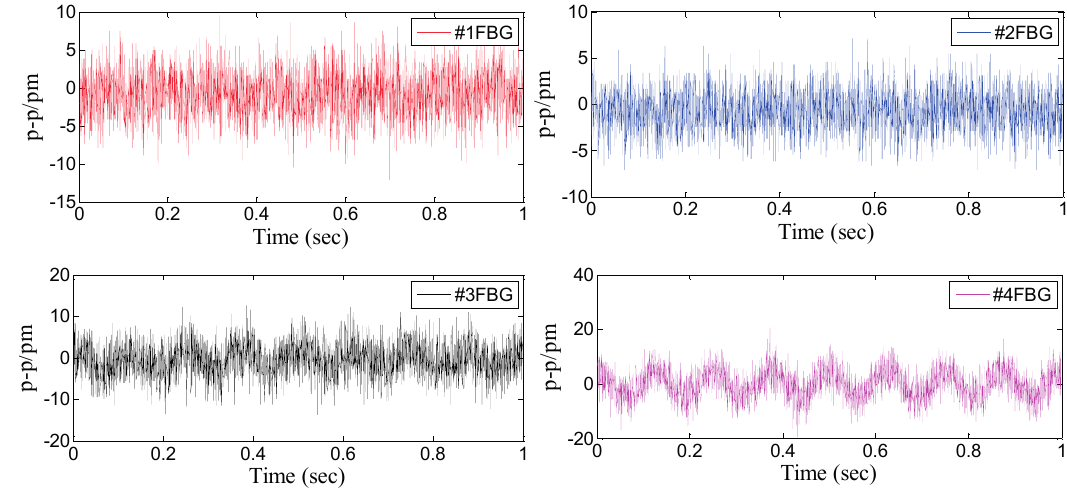
Figure 12. Time domain signal of each FBG under z -direction excitation with the acceleration—1 m/s 2 -8 Hz.